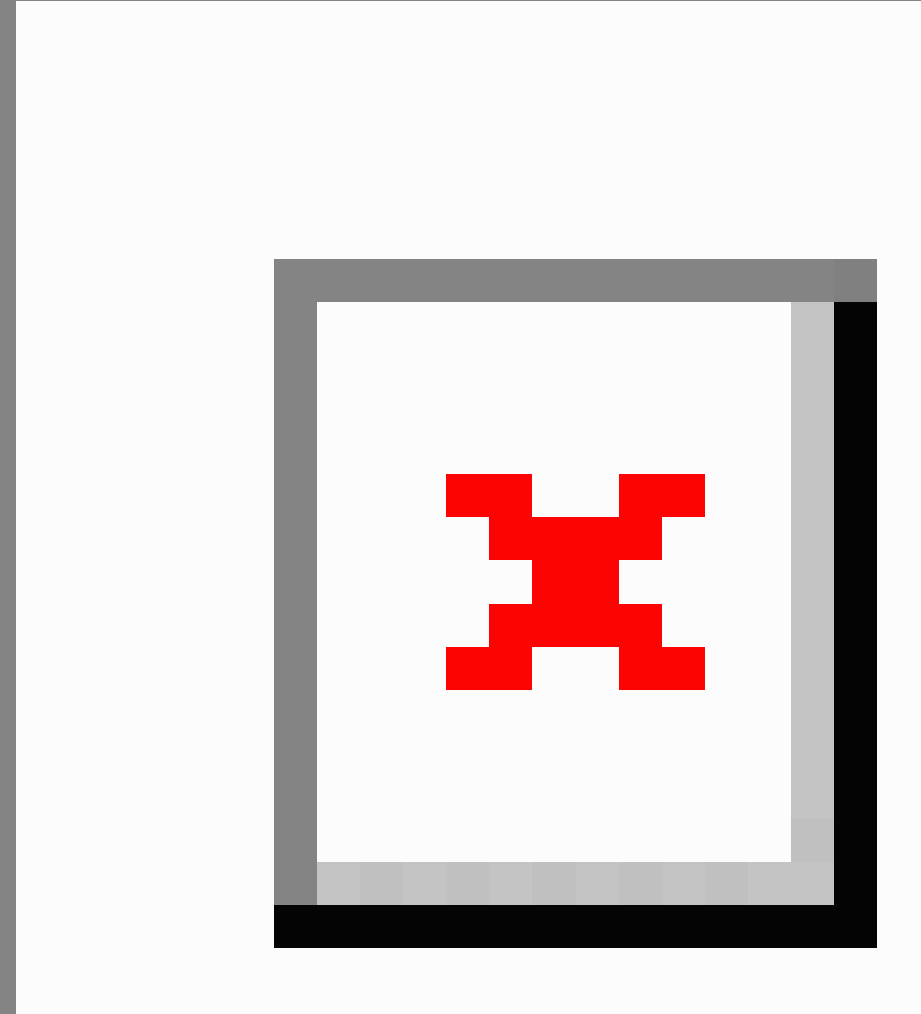
Figure 1. Homepage of